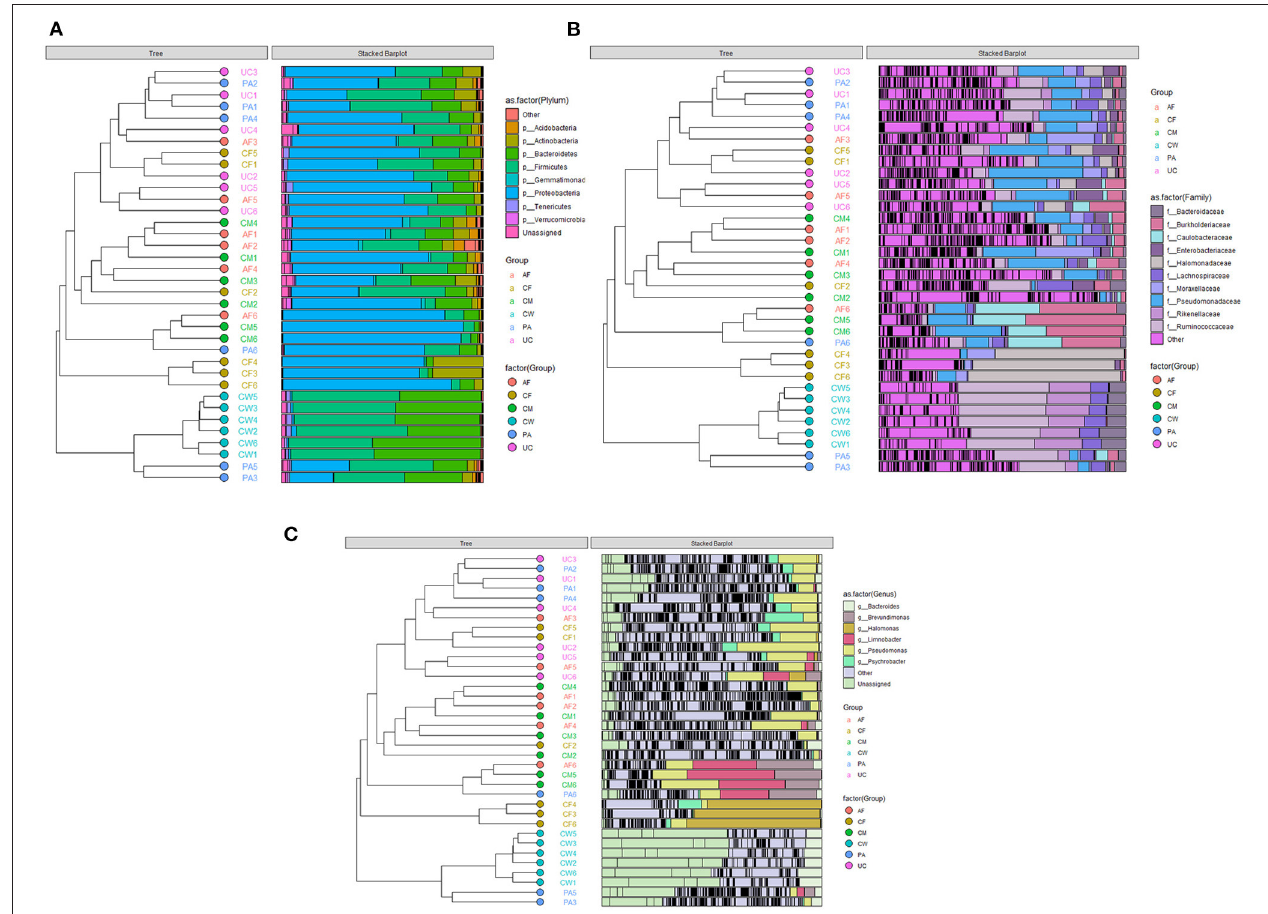
FIGURE 3 | Clustering graph based on Bray-Curtis distance and stacked bar charts showing the microbiome compositions of the six types of samples at the (A) phylum level, (B) family level, and (C) genus level. AF, amniotic fluid; CF, calf meconium; CM, colostrum; CW, cow feces; PA, placenta; UC, umbilical cord.